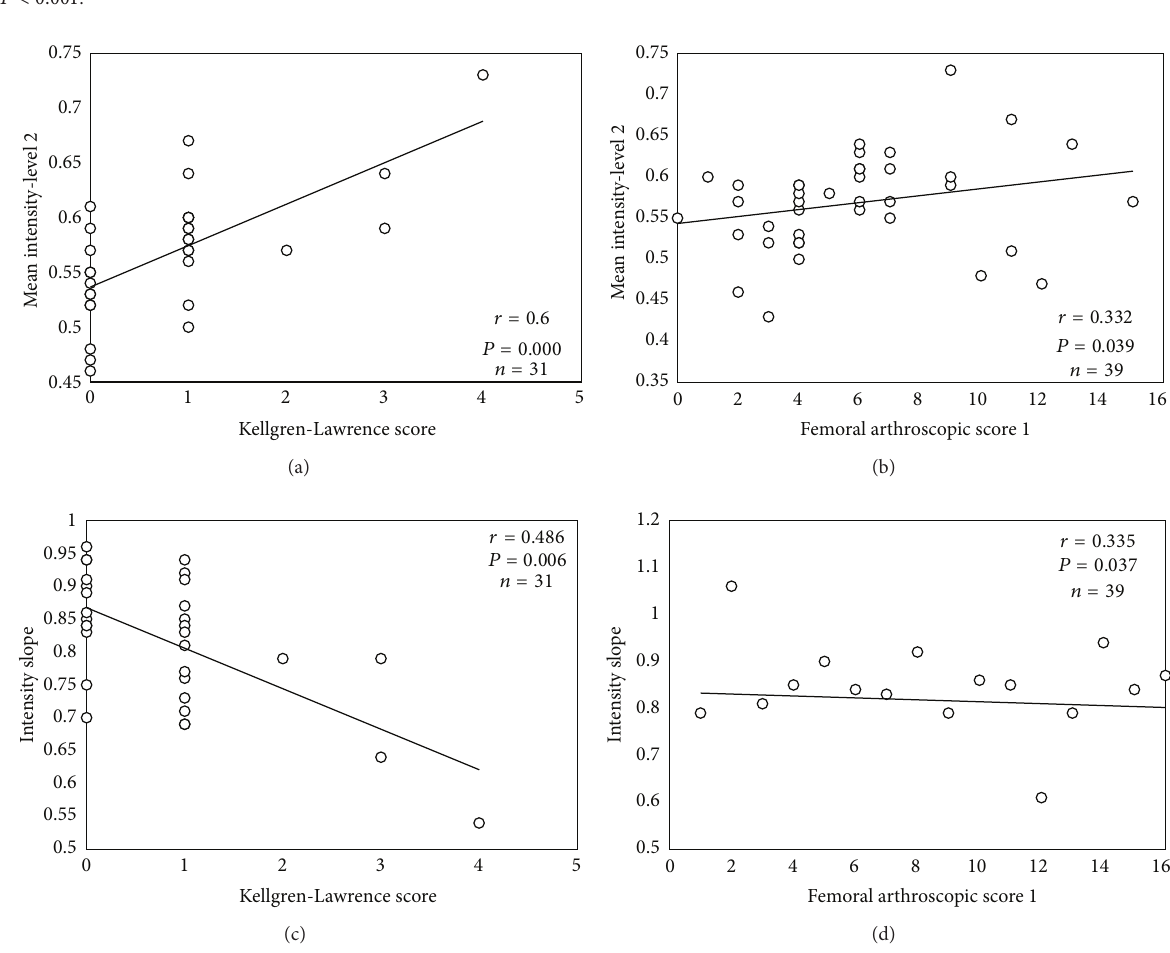
Figure2:(a)Relationshipbetweennormalizedmeanintensityvaluesoffemoralbonelevel2andKellgren-Lawrence(K-L)gradingorfemoral arthroscopic score 1 (FAS1) (b). Relationship between femoral subchondral bone intensity slope and K-L grading (c) or FAS1 (d). The slope was calculated from first 2 levels. Please note that the trendline in each plot is only for illustration